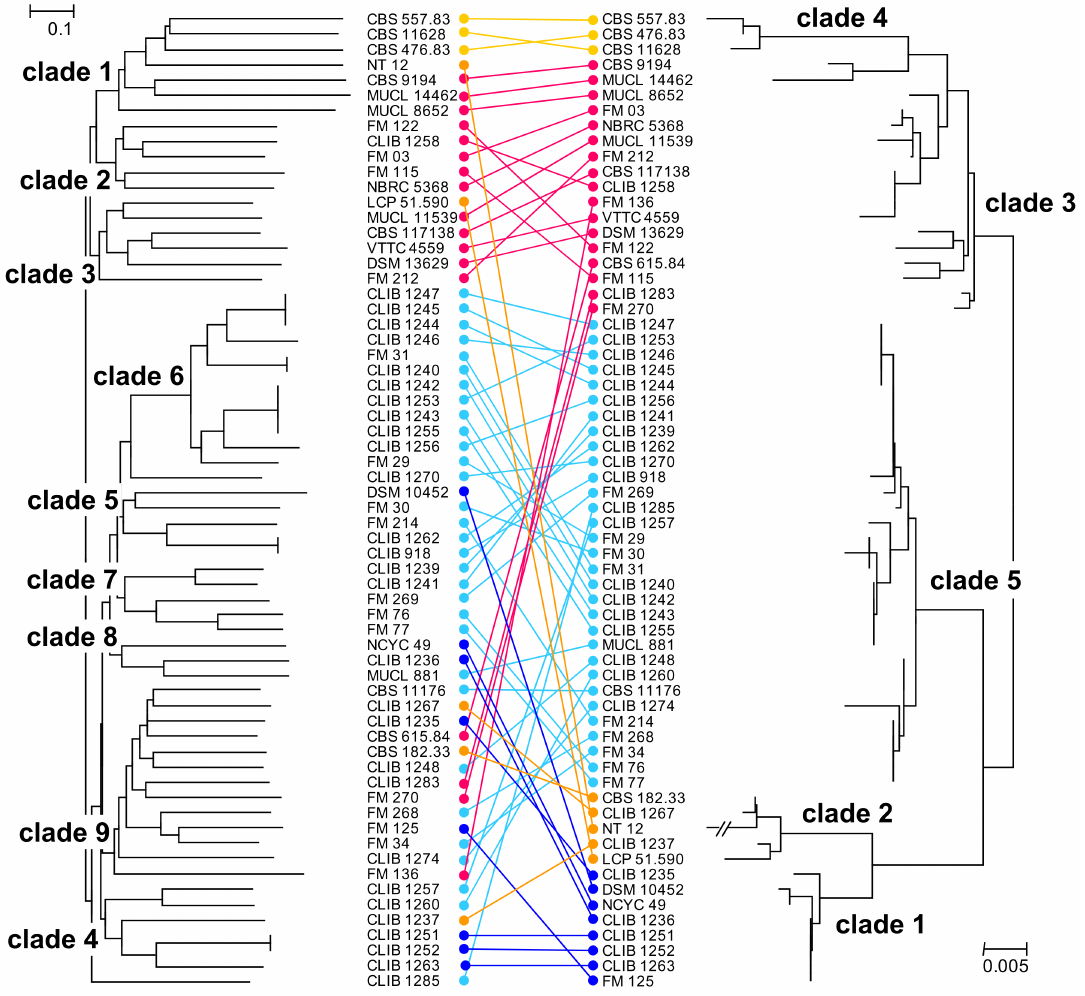
Figure 2. Comparison of NJ trees obtained by analysis of the microsatellite-like loci and MLST analyses of the G. candidum strains. Left, microsatellite analysis; right MLST analysis [9]. Taxon order was optimized manually using “Mega X” and strains that were not common to the two studies were removed. Connectors are coloured with respect to the MLST clades: dark blue, clade 1; orange, clade 2; pink, clade 3; yellow, clade 4; turquoise, clade